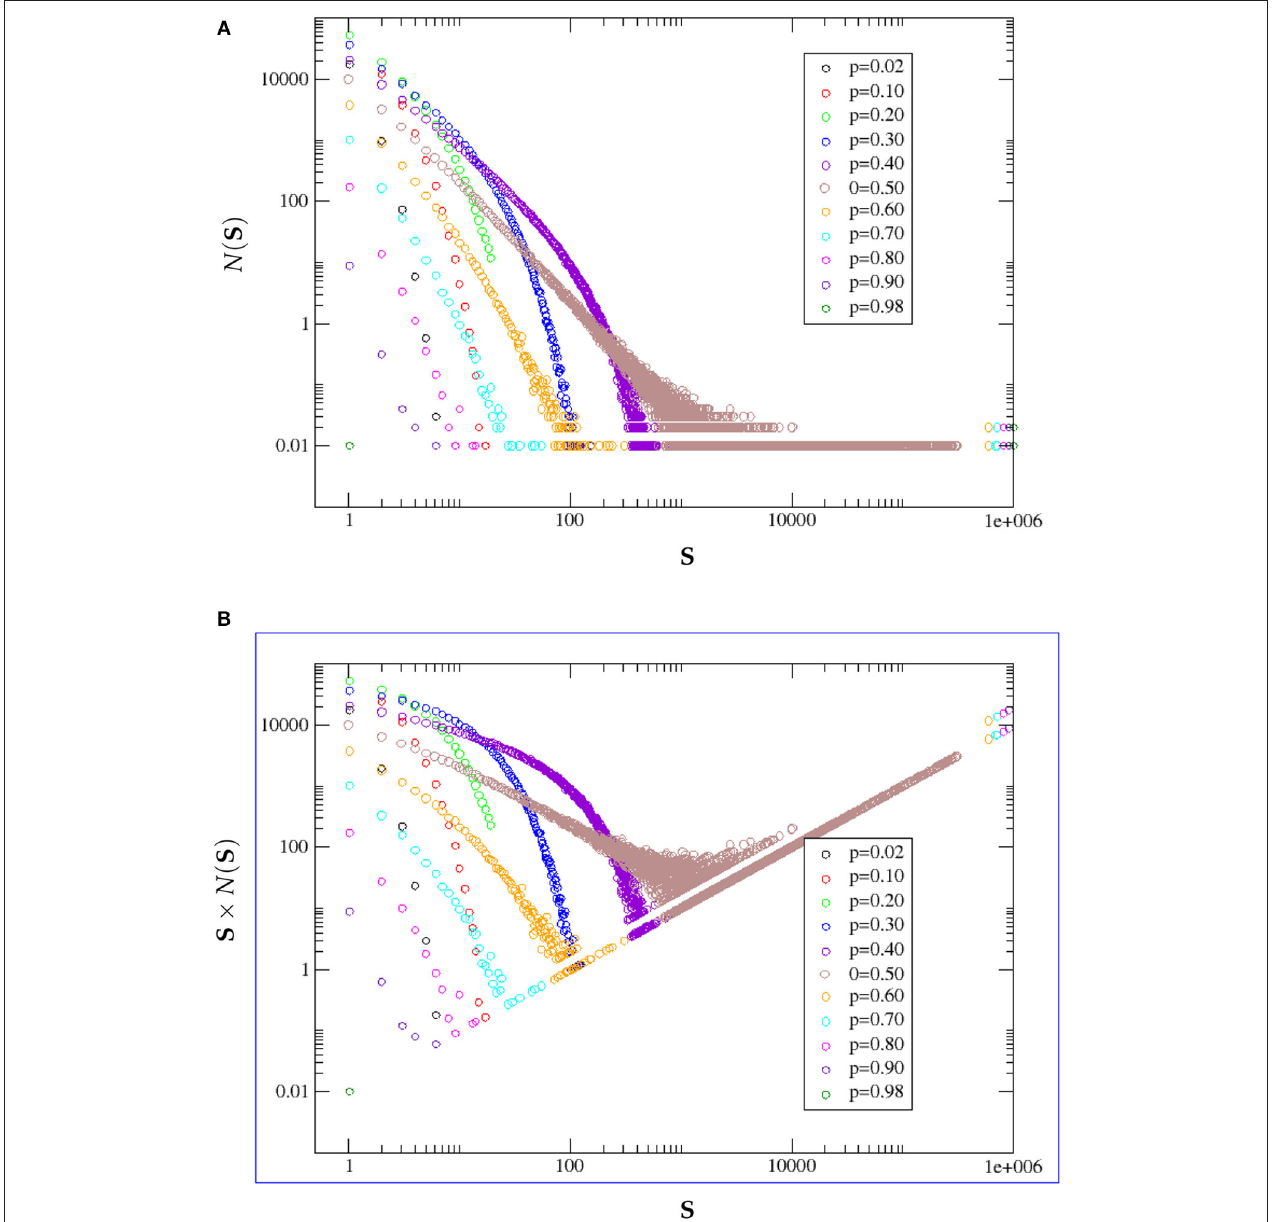
FIGURE 10 | (A) S represents cluster size. N ( S ) represents the number of clusters of a certain size. Based on our simulations, we plot the nature of variation of N ( S ) against cluster size S for different values of occupation probability p in double logarithmic scale. (B) N ( S ) × S , i.e., the total number of B sites in clusters of size S are plotted against S in double logarithmic scale. For each p, statistics were collected over 100 randomly generated binary matrix configurations.